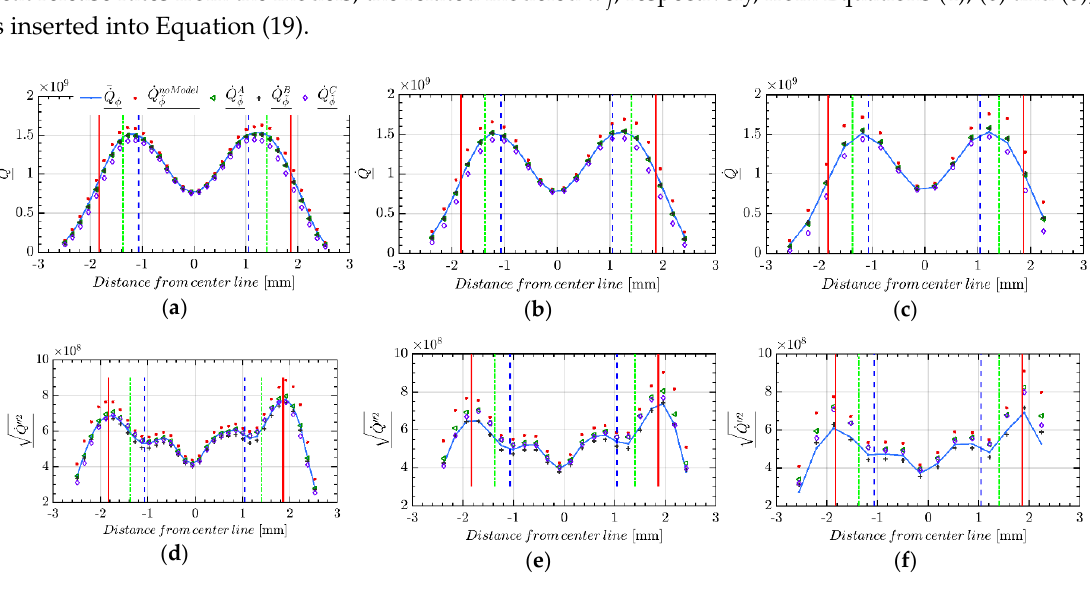
Figure 6. Heat release rate with units (kg/(ms 3 )): ( a , b , c ) Mean; and ( d , e , f ) RMS. Different filter widths are applied: ( a , d ) ∆/∆ DNS = 8; ( b , e ) ∆/∆ DNS = 12; and ( c , f ) ∆/∆ DNS = 18. The data are extracted at 𝑡 = 20𝑡 𝑗 . are applied: ( a , d ) ∆ / ∆ DNS = 8; ( b , e ) ∆ / ∆ DNS = 12; and ( c , f ) ∆ / ∆ DNS = 18. The data are extracted at t = 20 t j . Vertical lines are the same as in Figure Vertical lines are the same as in Figure 3.